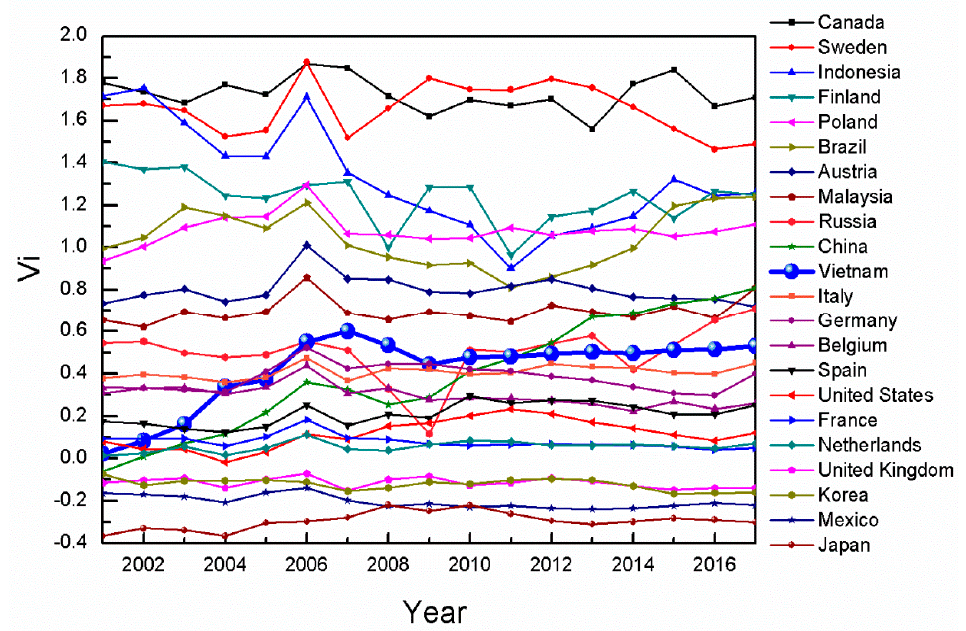
Figure 1. The comprehensive international competitiveness index for the world top 22 exporters of the wood processing industry for 2001–2017.